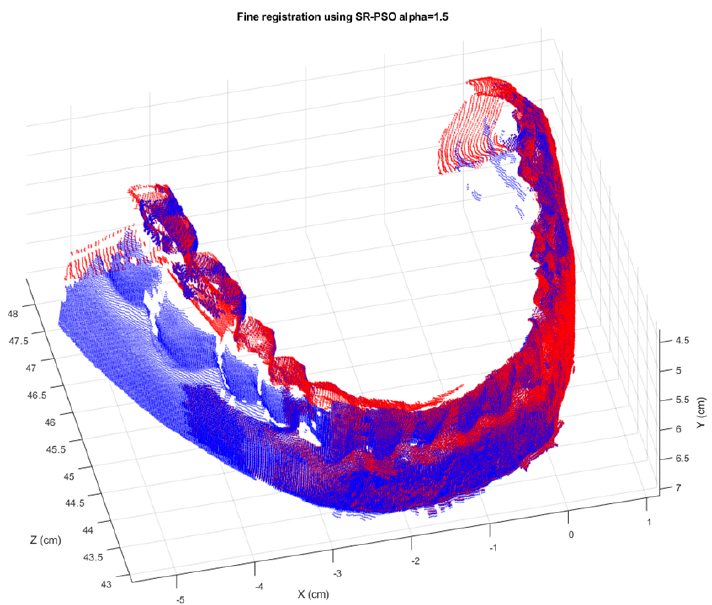
Figure 11. The final registration result of six consecutive views of the regular-tooth model from the SR-PSO with the ICP. Table 8. MSE from SR-PSO and PSO for the orthodontic-tooth model (the best value is in bold).